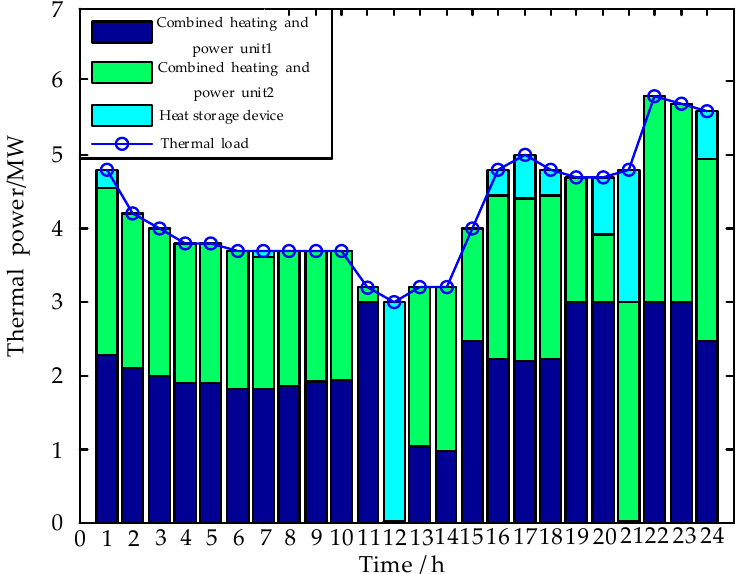
Figure 5. Power output scheduling curve of micro source.